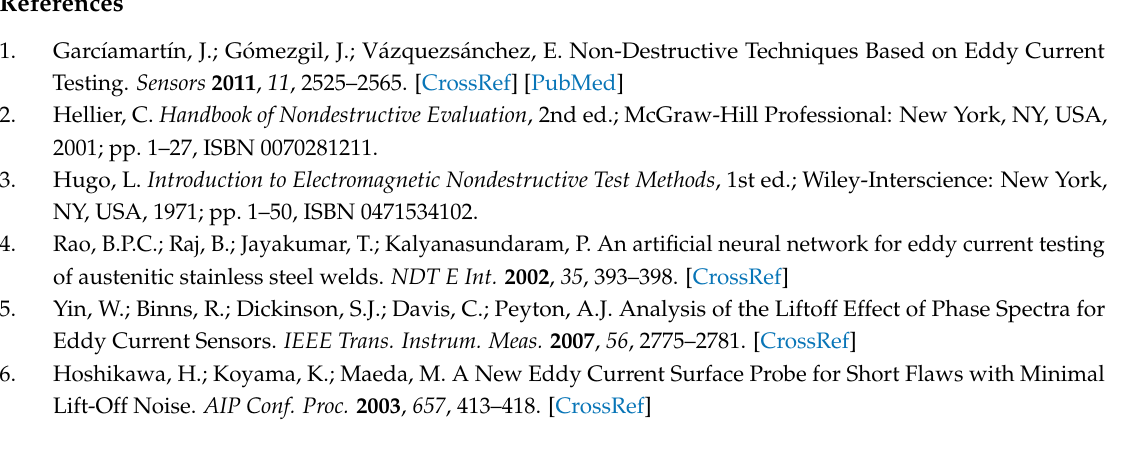
Figure 9. Lift-off effect for the z-components and x-component of Lorentz force. Here a lift-off is simulated as the probe-sample distance undergoes an increase of given amount then restores. ( a ) without defects and ( b ) with the same defect at different lift-off